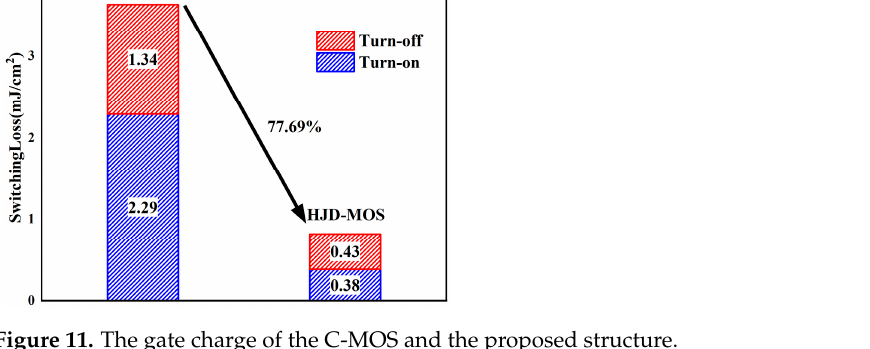
Figure 11. The gate charge of the C-MOS and the proposed structure. Table 2 Summarizes the electrical characteristics of the C-MOS and the proposed structure. Table 2. Device Characteristics.